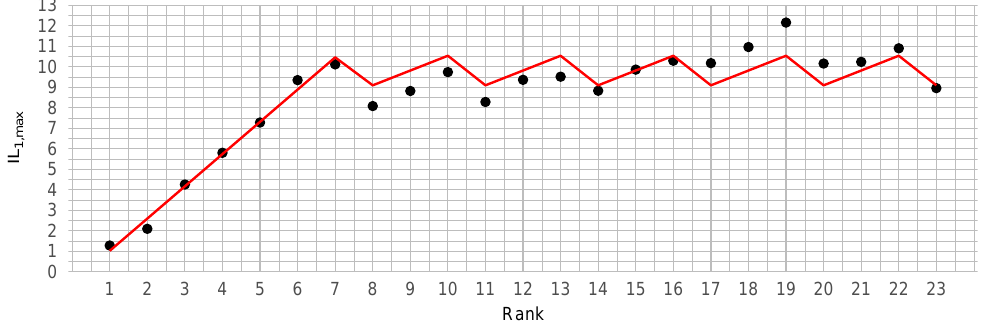
Figure 4. Estimated coefficients (dots) for rank wise maximum internode length (IL 1,max ) and model fit (red line, Equation